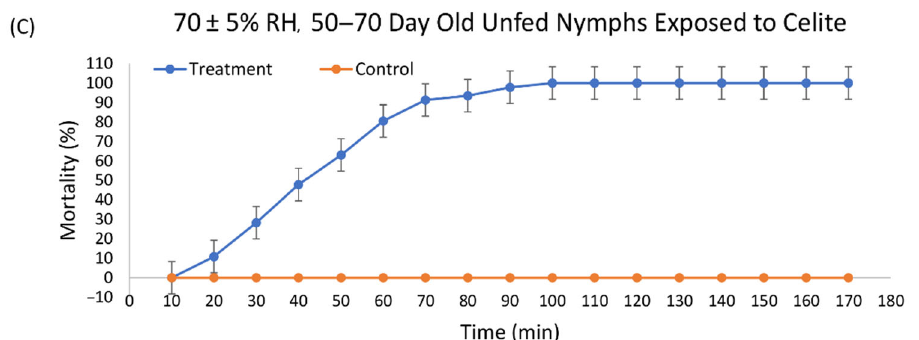
Figure 2. Mortality over time of unfed nymphal Ixodes scapularis exposed by dipping into Celite 610 with ( A ) ticks 6–10 days past last molt at 50 ± 5% relative humidity (RH), ( B ) ticks at 50–70 days past last molt at 50 ± 5% RH, and ( C ) ticks 50–70 days past last molt at 70 ± 5% RH. Probit models were used to determine the time to 50% mortality (LT 50 ) and time to 90% mortality (LT 90 ) (Table 1). The LT 50 for 6–10 d old unfed nymphs at 50% RH was 66.84 min (95% CI 62.12 to 71.43 min). The LT 90 was 113.42 min (95% CI 106.49 to